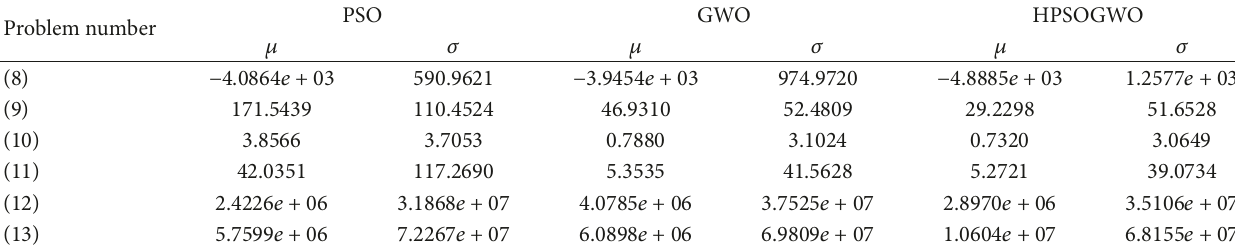
Table 7: PSO, GWO, and HPSOGWO statistical results of multimodal benchmark